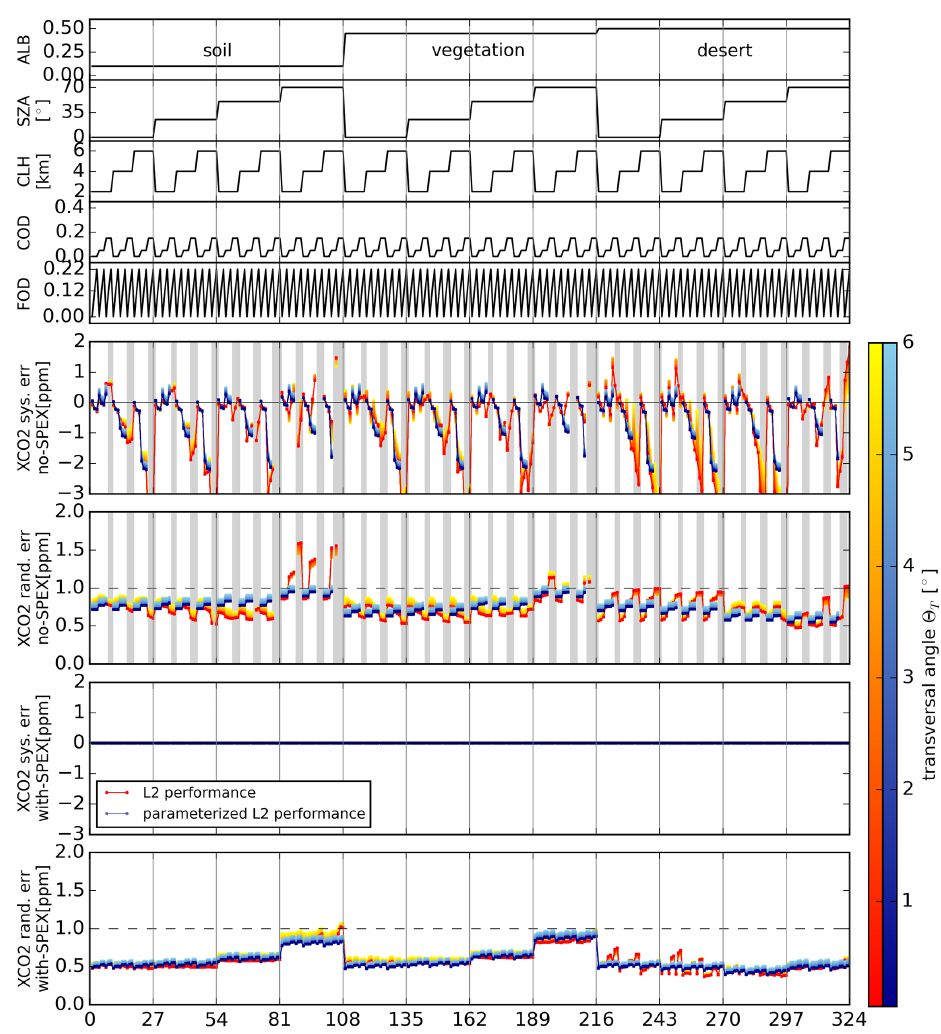
Figure 11. Parameterised (blue colour scale) NanoCarb X CO systematic (sixth and eighth panels) and random errors (seventh and ninth 2 panels) compared to exact L2 error retrieval results (red colour scale). Results are plotted as a function of the situation number: the five top panels detail the ALB (0.7µm), SZA, CLH, COD and FOD values defining all 324 situations. Grey-shaded areas denote situations for which retrievals did not satisfactorily converge or situations that were filtered out according to the retrieved COD and FOD